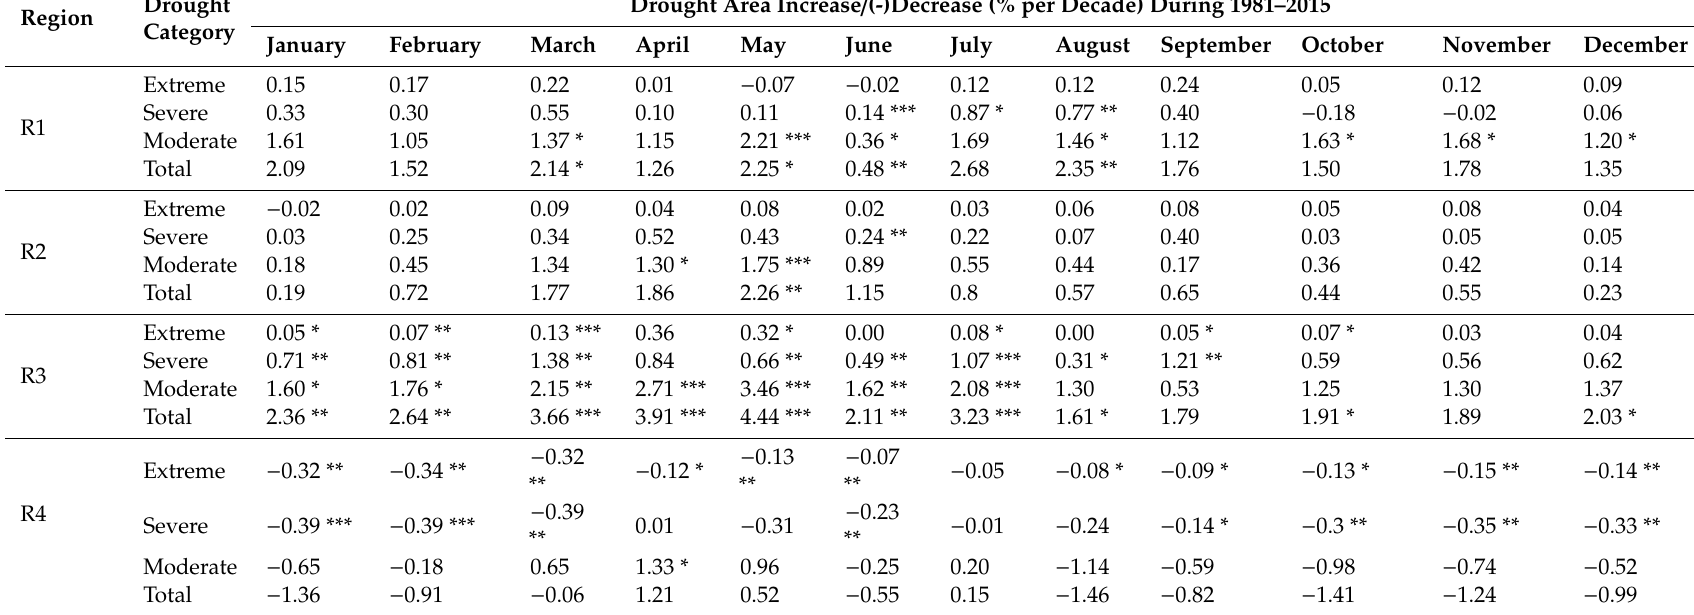
Table 7. Trends per decade regional series of the monthly drought